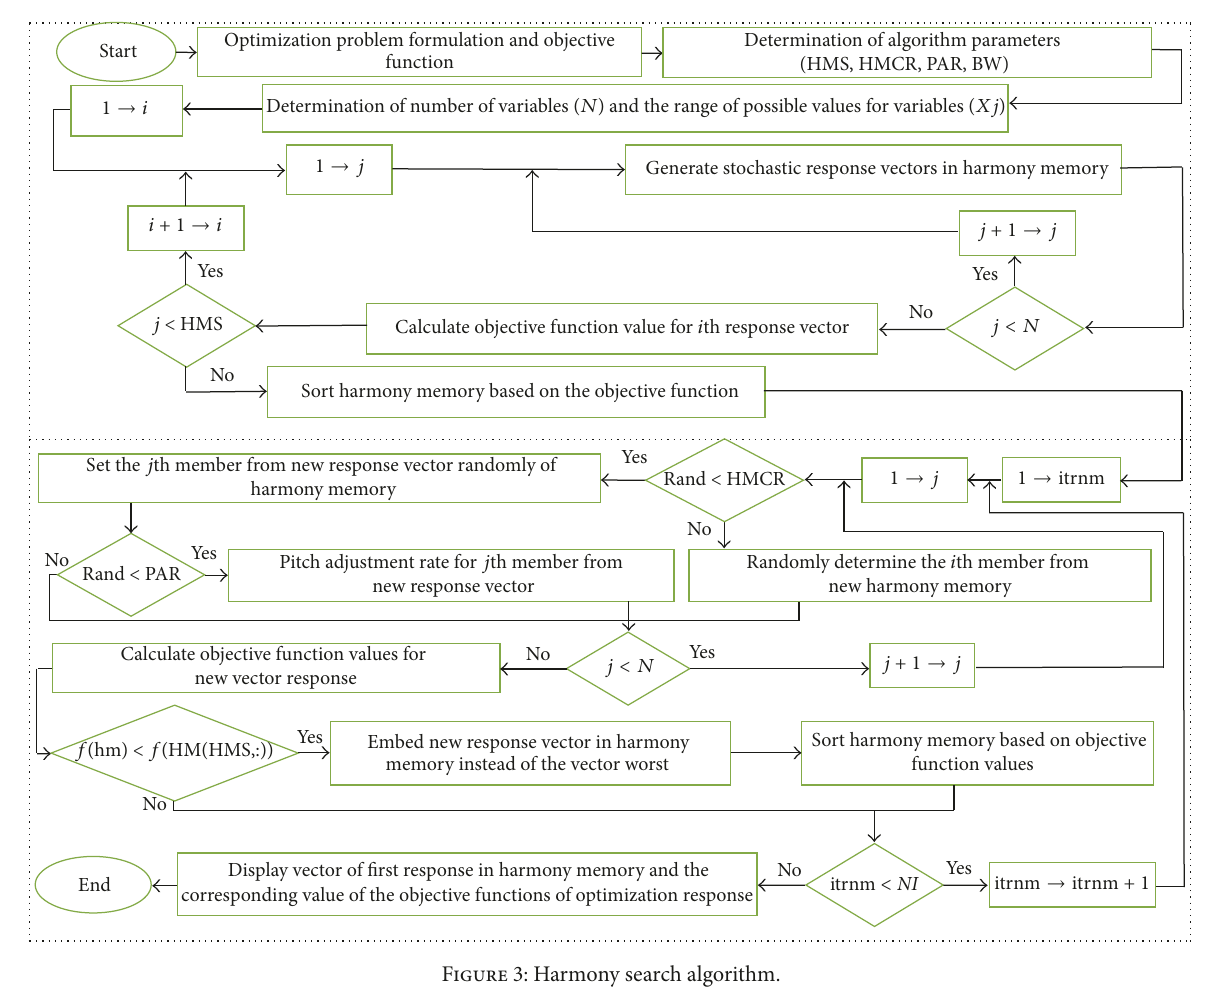
Figure 3: Harmony search algorithm.